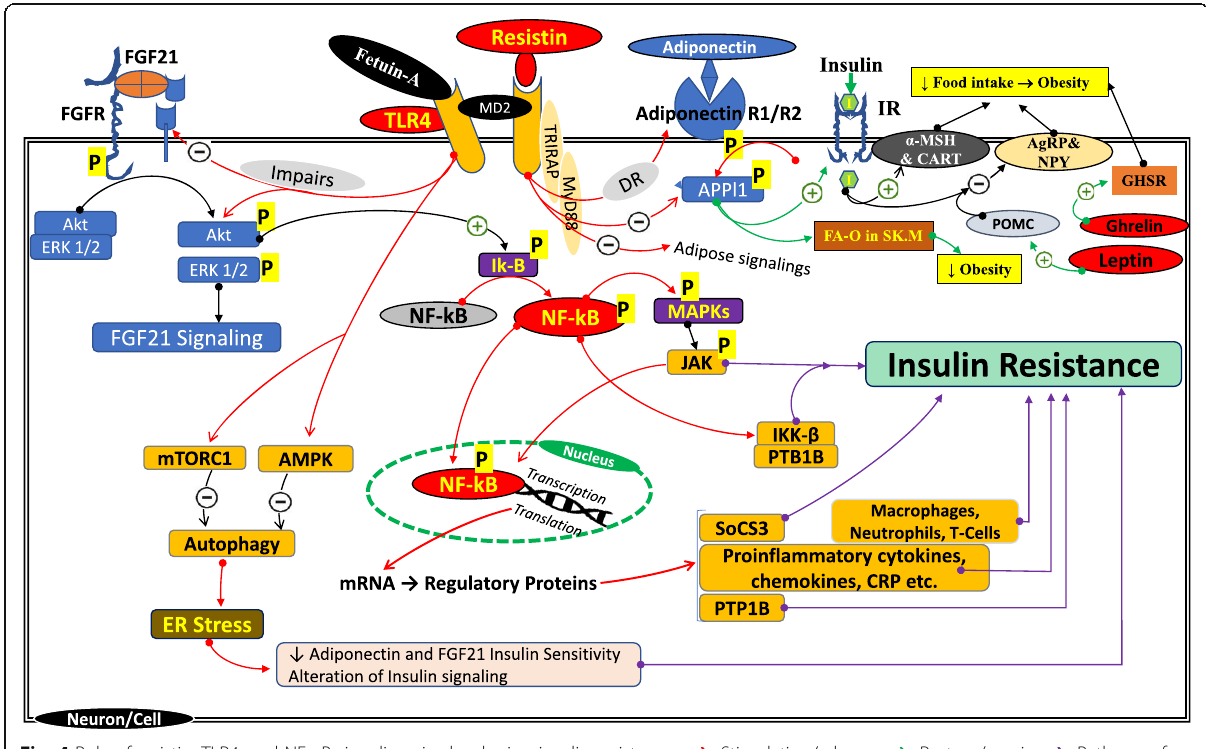
Fig. 4 Role of resistin, TLR4, and NF- κ B signalings in developing insulin resistance. : Stimulation/release; insulin resistance; : Physiological signalings. : Stimulation; : Inhibition. FGF21: Fibroblast growth factor 21; FGFR fibroblast growth factor receptor gene, Akt protein kinase B, ERK extracellular signal-regulated kinases, MD2 myeloid differentiation factor 2, TLR4 Toll-like receptor 4, NF- kB nuclear factor kappa-light-chain-enhancer of activated B cells, Ik-B I κ B kinase, mTORC1 Mammalian target of rapamycin complex 1, AMPK AMP- activated protein kinase, PI3K phosphatidylinositol-3-kinase, JAK c-Jun N-terminal kinases, MyD88 myeloid differentiation primary response 88, DR diabetic retinopathy, APPl1 adaptor protein, phosphotyrosine interacting, IR insulin resistance, α -MSH & CART α -melanocyte-stimulating hormone & cocaine and amphetamine-regulated transcript, AgRP & NPY Agouti-related protein & neuropeptide Y, GHSR growth hormone secretagogue receptor, POMC proopiomelanocortin, FA-O in SK.M, skeletal muscle lipid oxidation, SoCS3 suppressor of cytokine signaling 3, PTP1B protein tyrosine phosphatase 1B, ER endoplasmic